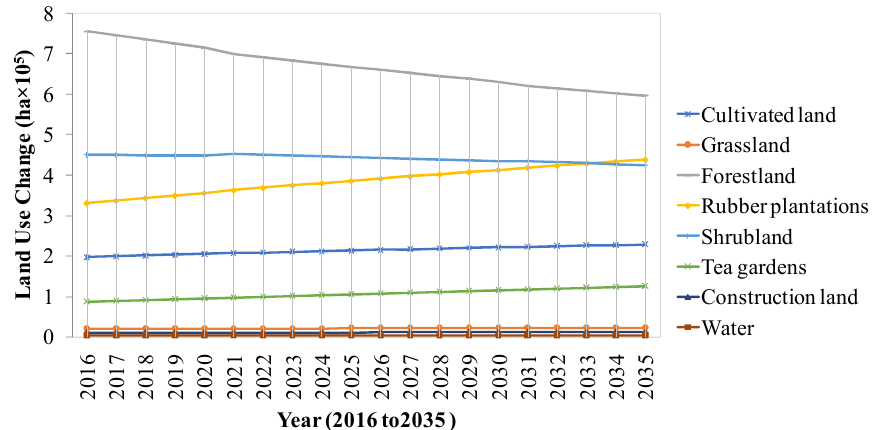
Figure 7. Land use forecast for Xishuangbanna region for the next 20 years (unit: ha or 10 4 m 2 ). Area under forestland shows a downward trend and is the largest change over the 20 years, with the areal reduction amounting to 158,535 ha (158,535 × 10 4 m 2 ). Conversely, the areas under rubber plantations, tea gardens, and cultivated land increase, with rubber plantations showing the highest increase (by 108,450 ha (108,450 × 10 4 m 2 )). The areas un-